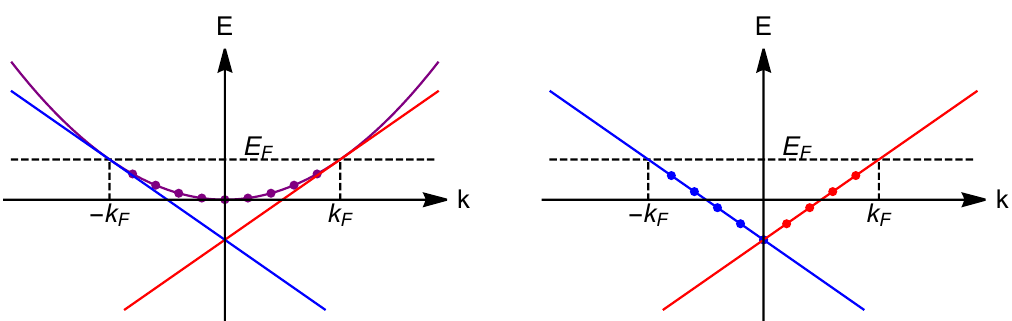
Figure 2: Left panel: Dispersion relation for a parabolic band, with the Fermi energy E and momenta ± k . The dots indicate filled levels in the ground state. The red F F and blue lines are linear approximations near Fermi points. Right panel: Linear dispersion relation for the Luttinger model, with filled